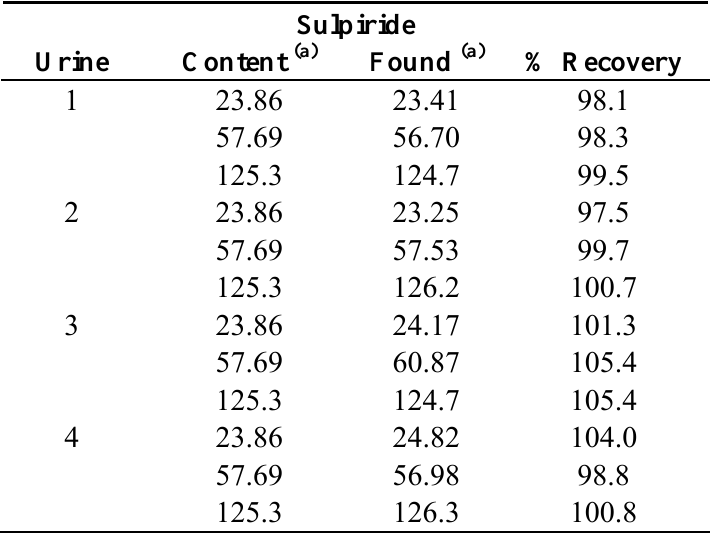
Table 6. Determination of sulpiride in